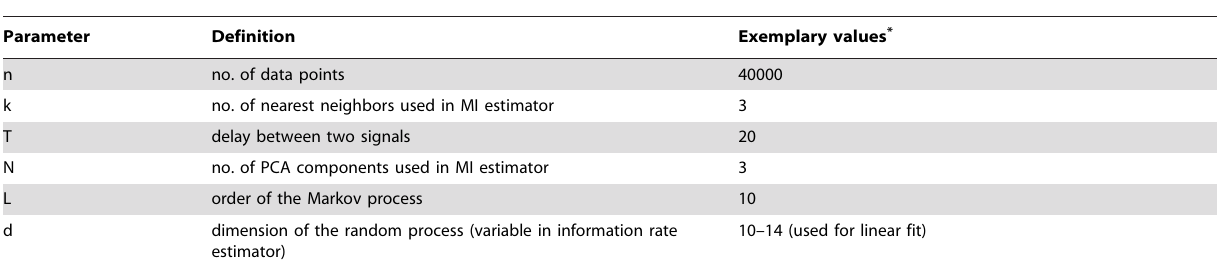
Table 2. Parameters used in information rate estimator.